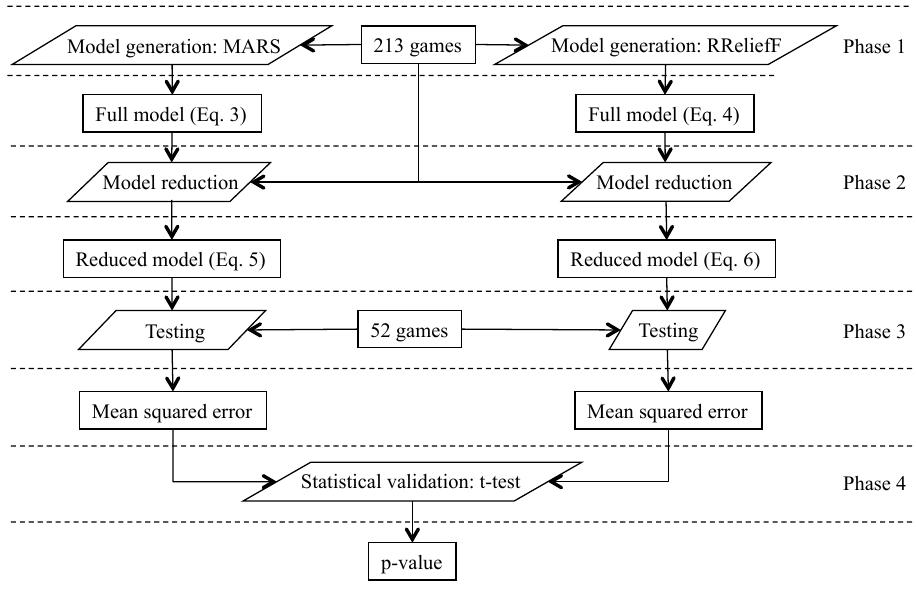
Figure 3: Project Architecture Table 2: The highest correlation coefficient table for soccer variables Variables Correlation